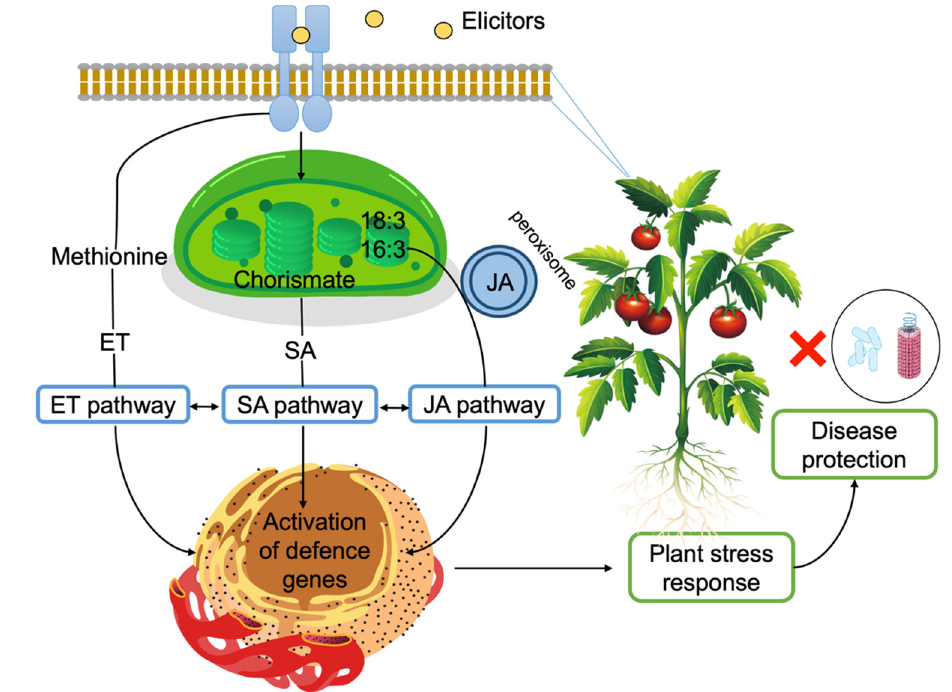
Figure 7. Induction of plant defense responses via elicitors. Elicitors are recognized on the plasma membrane. Jasmonic acid (JA) biosynthesis starts with α -linolenic acid (18:3) or hexadecatrienoic acid (16:3) in the chloroplast. Conversion to JA takes place in the peroxisome [201]. Salicylic acid (SA) biosynthesis starts with chorismate in the chloroplast and SA is transported into the cytosol [202]. Ethylene (ET) biosynthesis starts with methionine and ET is recognized by receptors on the endoplasmic reticulum. All three pathways eventually lead to defense gene expression and evidence suggest crosstalk between these pathways [203].